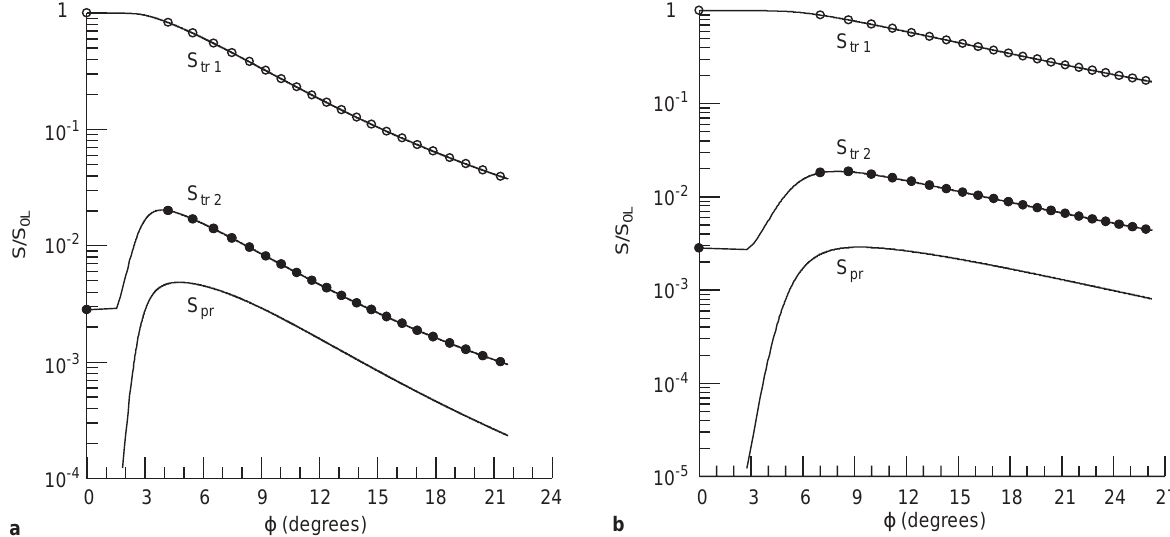
Fig. 4a, b. The dependence of fluxes of trapped and precipitated electrons on u for weak di(cid:128)usion for di(cid:128)erent initial spread over energies: a D v = v 0 (cid:136) 0 : 3 ; b D v = v 0 (cid:136) 0 : 6 ; other parameters are as in Fig. 2